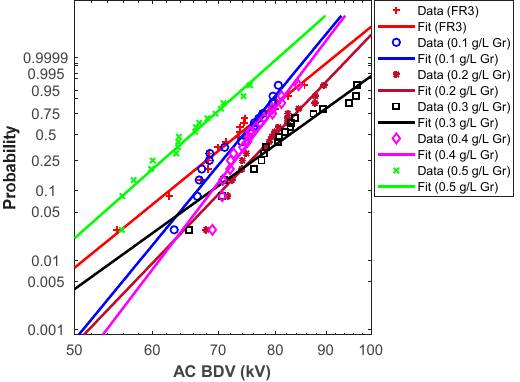
Figure 4. Graphene NFs Weibull probability plots.